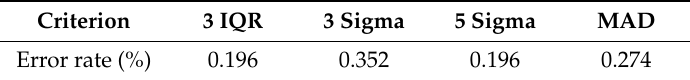
Table 3. Gross error rate of BJFS station under di ff erent